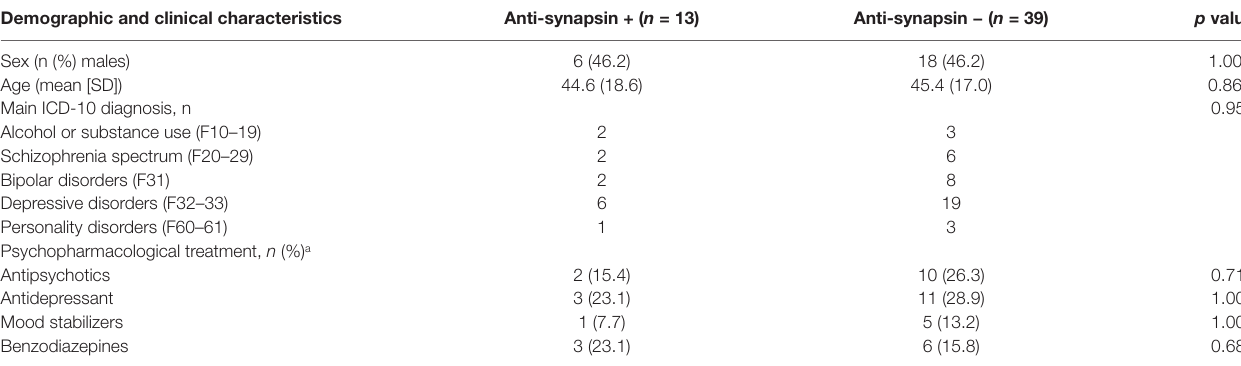
TABLE 1 | Demographic and clinical data of anti-synapsin positive and negative patients. Demographic and clinical